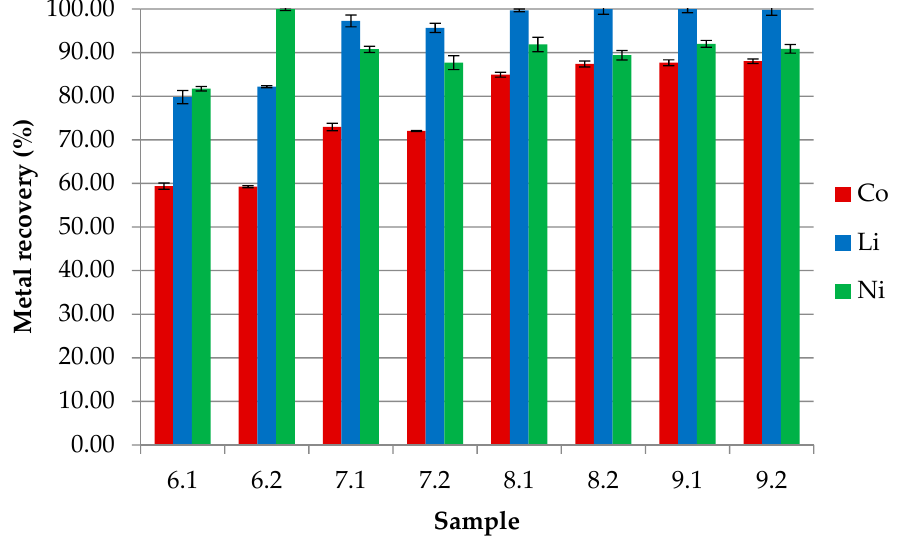
Figure 5. Co, Li, and Ni recovery degrees after battery powder leaching in 1.5 M H 2 SO 4 in the presence of reducers of 5 g C 5 H 8 O 4 and 3 cm 3 /5 cm 3 /10 cm 3 /15 cm 3 perhydrol.